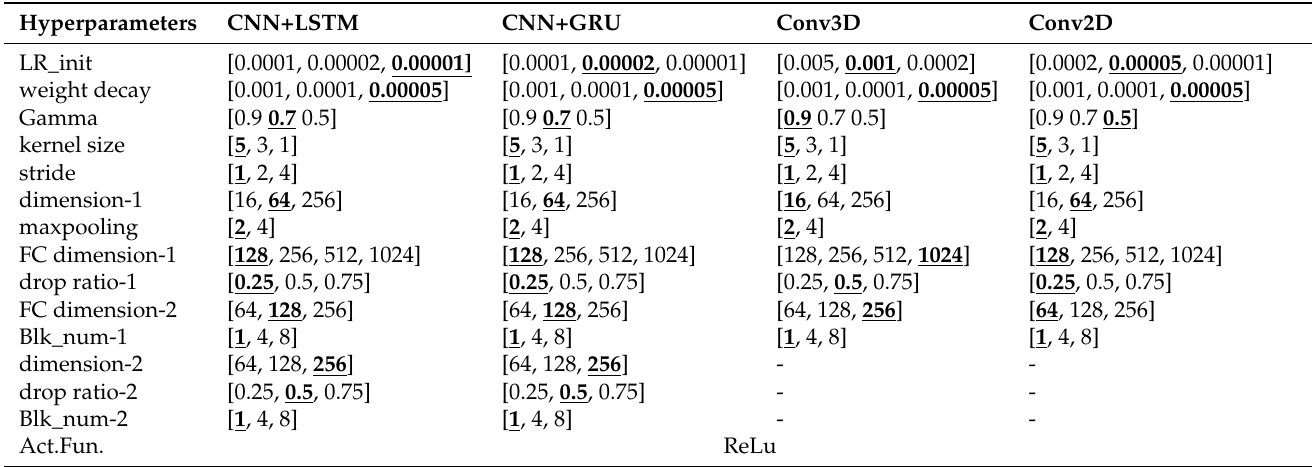
Table 12. The ablation for parametric uncertainty, where the optimal parameter configuration after the parametric uncertainty ablation is marked with underline and